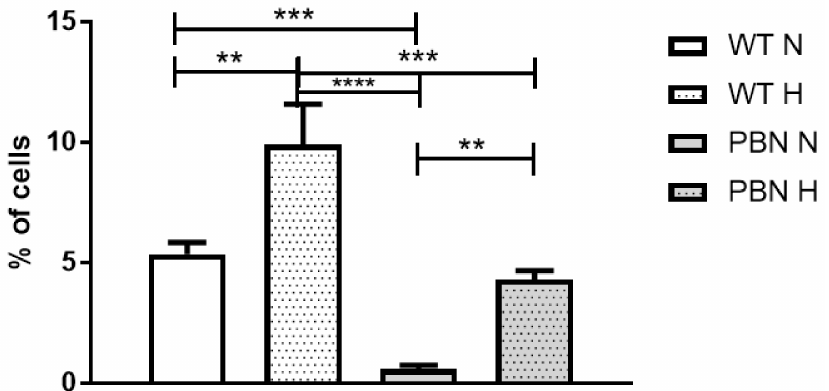
Figure 4. Cell apoptotic rate in the SkMDS/PCs populations under study: WT and PBN-conditioned cells under the standard (N) in vitro and hypoxic conditions (H). ** significant at p value < 0.01, *** significant at p value < 0.001, **** significant at p value <